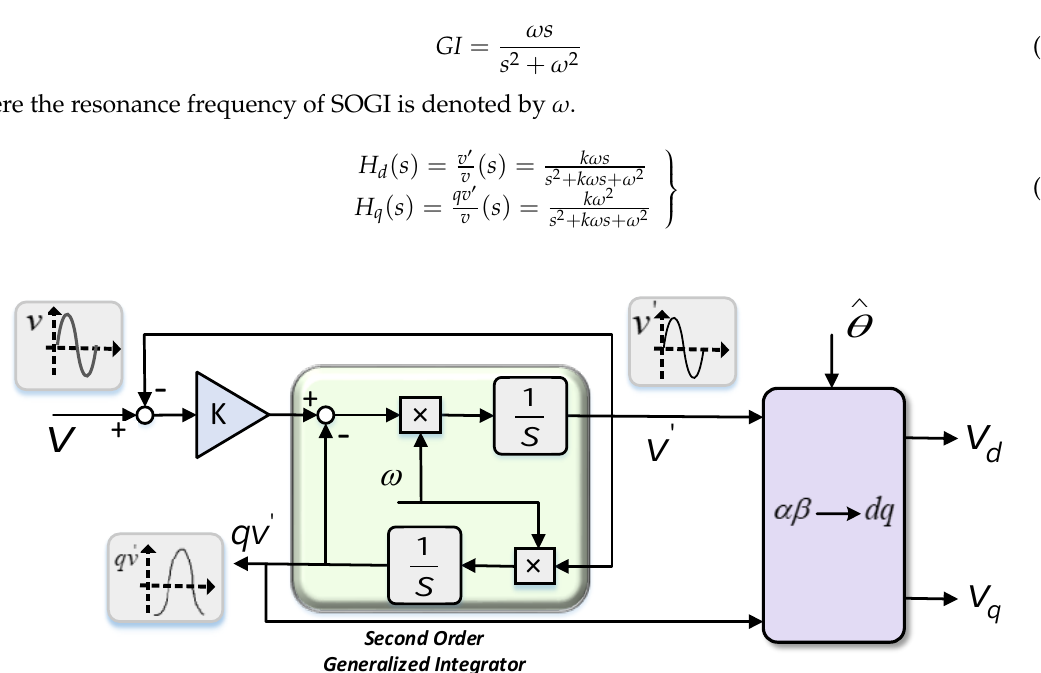
Figure 5. Structure of the Second Order Generalized Integrator (SOGI) PLL.